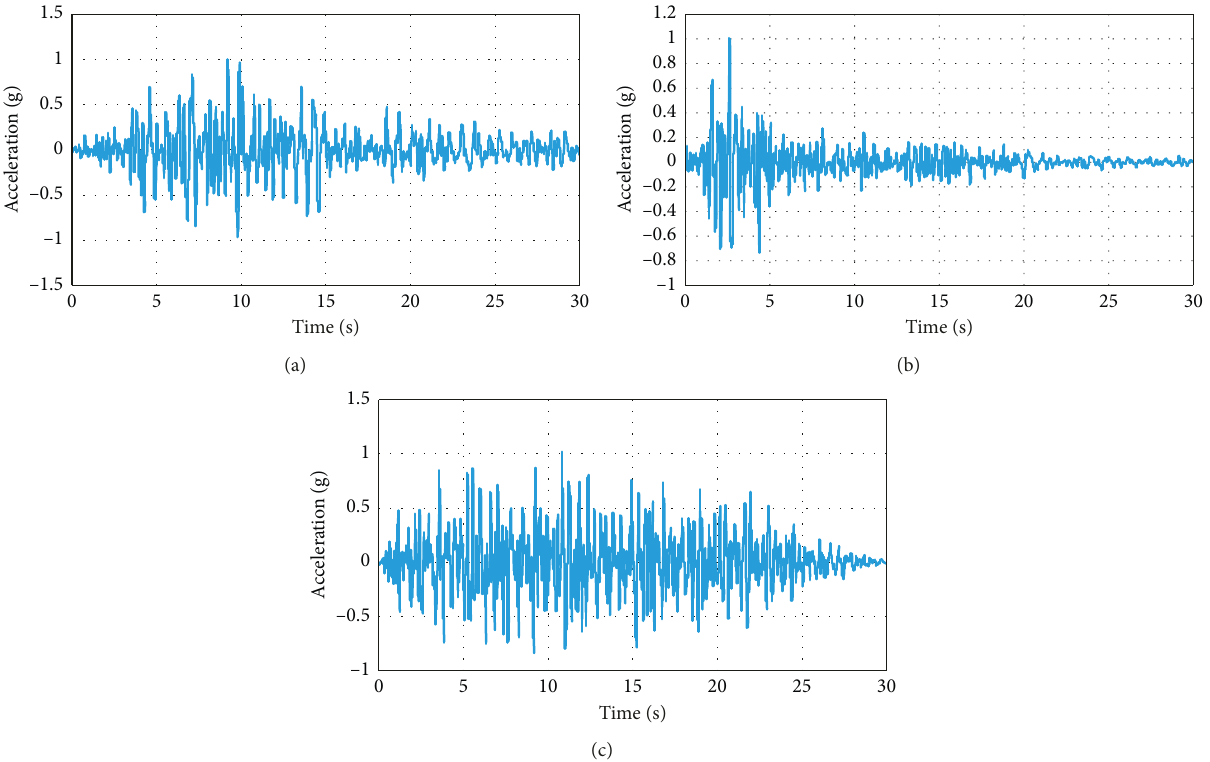
Figure 4: Acceleration time history curve of the three loading waves. (a) The Taft wave. (b) The Castaic wave. (c) The artificial seismic